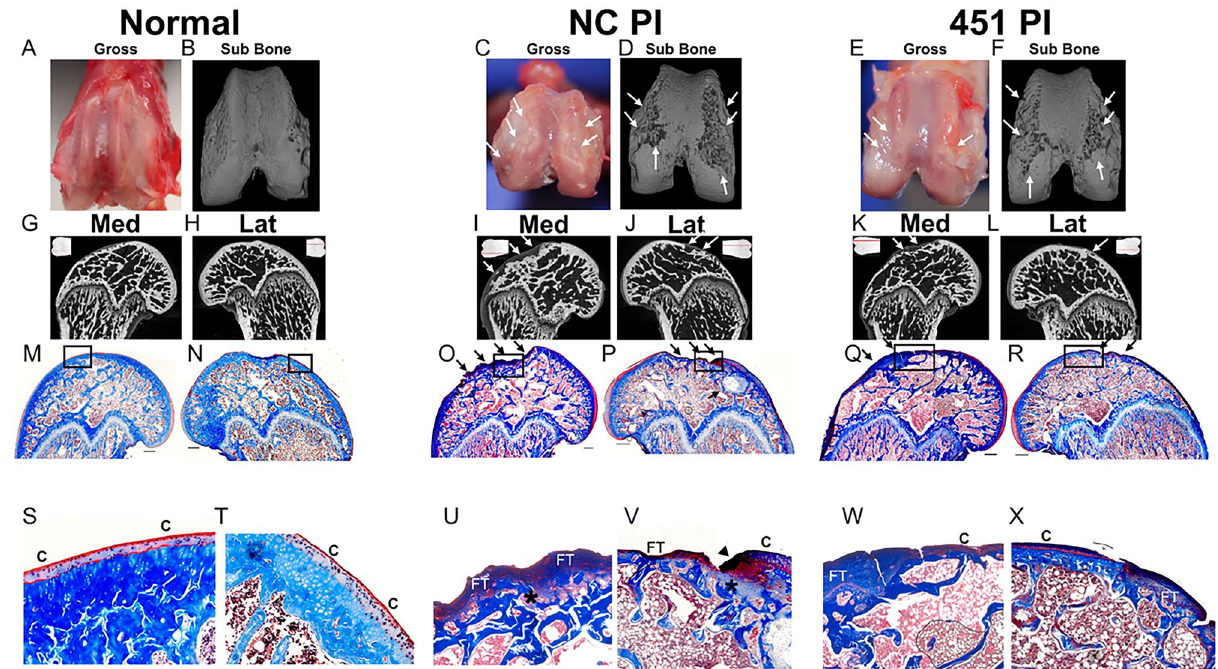
Figure 2. Gross images, micro-CT, and histology from the prophylactic cohort of the miR-451-PI study. Gross images ( A , C , E ), 3D micro-CT rendering ( B , D , F ), medial and lateral micro-CT images ( G – L ). A shadow projection of the femur is included in the top corner of each micro-CT image with a red line to indicate the location each micro-CT image is taken from within the joint ( G – L ). Masson’s trichrome histology ( M – R ) and the respective zoomed-in images as depicted by the black box ( S – X ) for the normal control, NC-PI, and 451-PI groups, respectively. Scale bar: 500 μm. Subchondral bone (sub bone); medial (med); lateral (lat); arrows, areas of cartilage erosion or subchondral bone remodeling; arrowheads, abnormal cartilage remodeling; C, cartilage; FT, fibrotic tissue; asterisk, microfracture.